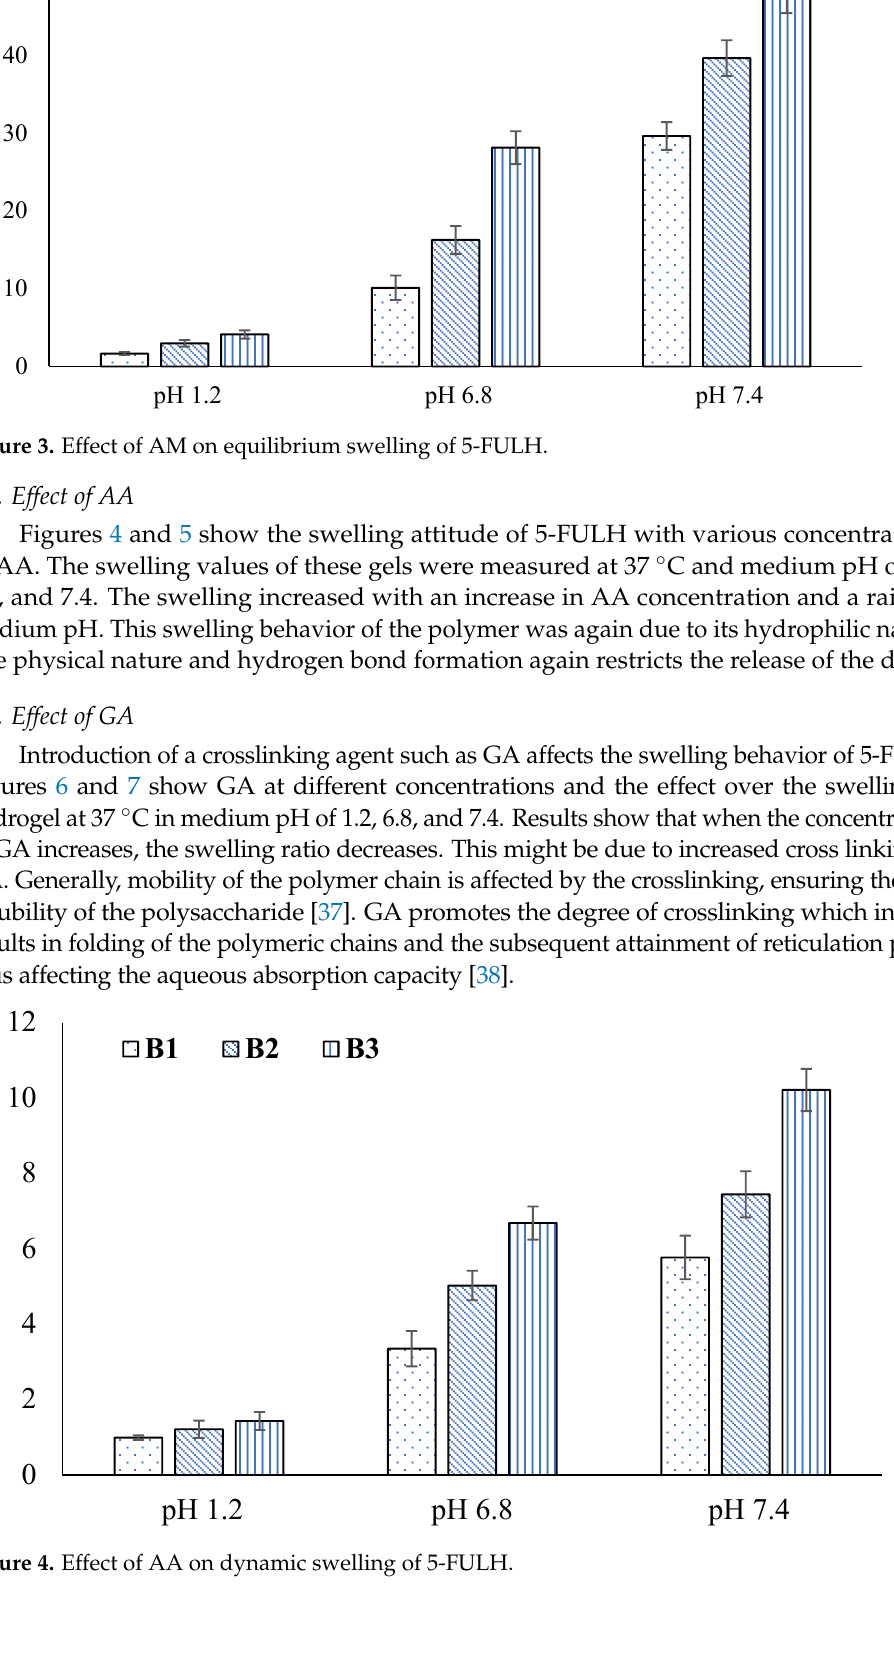
Figure 5. Effect of AA on equilibrium swelling of 5-FULH. 2.7. Effect of GA Introduction of a crosslinking agent such as GA affects the swelling behavior of 5- FULH. Figures 6 and 7 show GA at different concentrations and the effect over the swell- ing of hydrogel at 37 °C in medium pH of 1.2, 6.8, and 7.4. Results show that when the concentration of GA increases, the swelling ratio decreases. This might be due to increased cross linking of GA. Generally, mobility of the polymer chain is affected by the crosslink- ing, ensuring the low solubility of the polysaccharide [37]. GA promotes the degree of crosslinking which in turn results in folding of the polymeric chains and the subsequent attainment of reticulation point, thus affecting the aqueous absorption capacity [38].